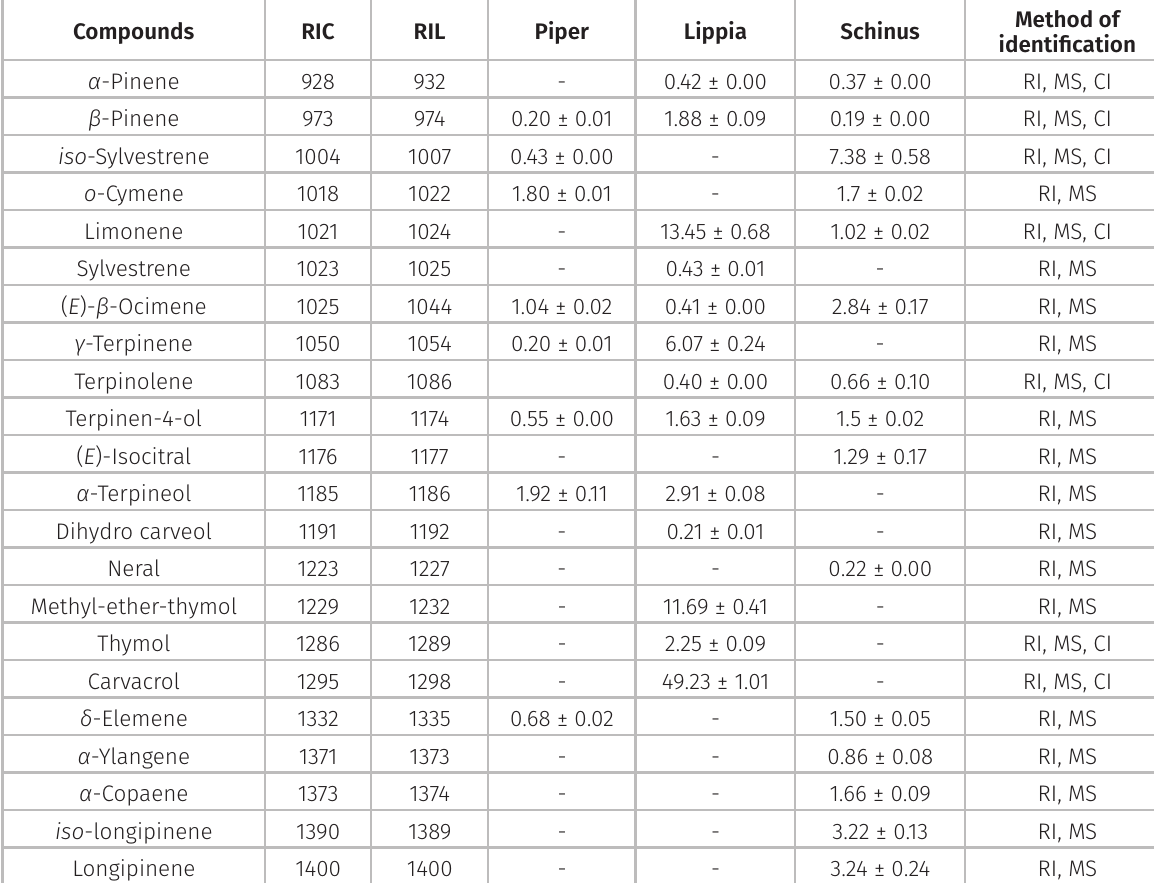
Table I. Percentage composition, yield of essential oils from Piper aduncum , Lippia sidoides and Schinus